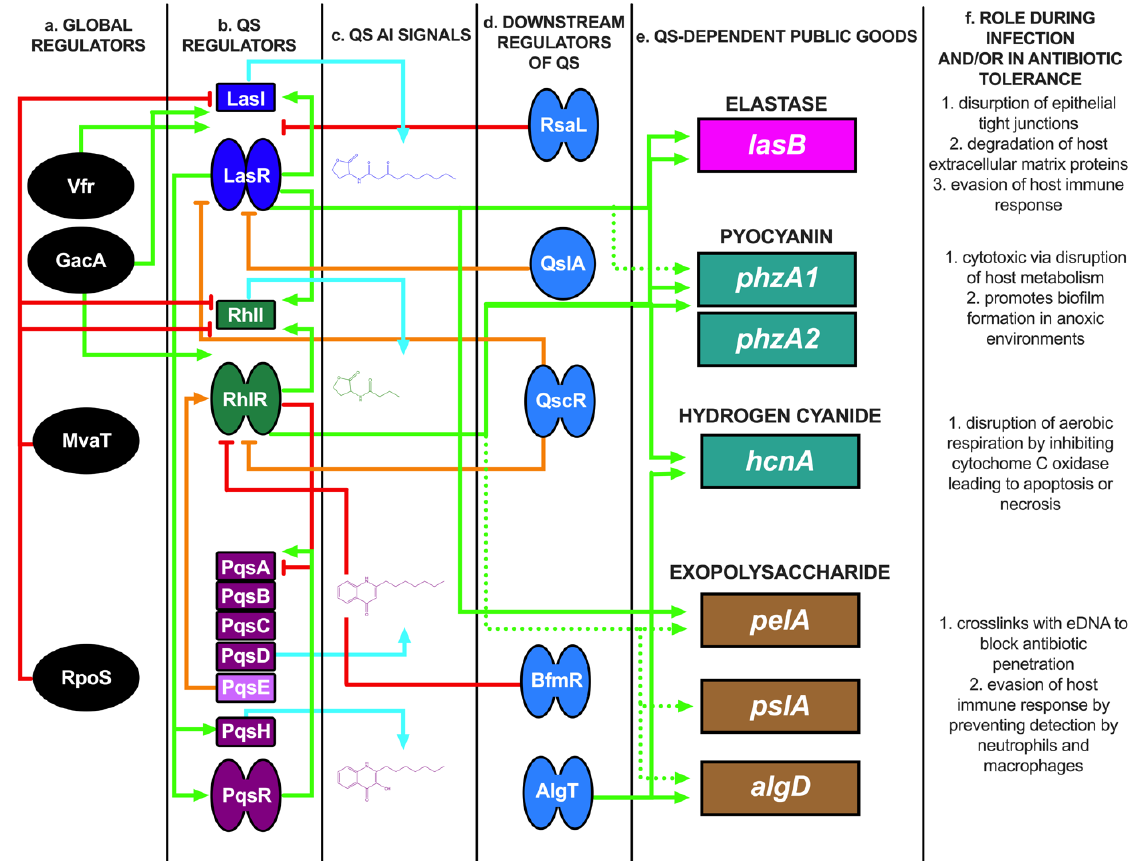
Figure 1. What regulates the regulators? Six steps from global gene regulation to infection and antibiotic tolerance. ( a ) A selection of well-characterized global transcriptional regulators that directly regulate the expression of the las and rhl QS systems. ( b ) The three main branches of QS regulators all regulate their own signal production through an autofeedback mechanism that results in the upregulation of their respective AI signals, as shown in ( c ). There is an extensive interplay between the three QS pathways. PqsE is colored light purple, distinct from the rest of the PQS pathway, because of its role outside of the biosynthesis of PQS related to regulating RhlR function. ( c ) The three main AI signals that bind to their cognate receptors in ( b ). HHQ, the precursor to PQS synthesis is shown because it can also act as an activator of PqsR. ( d ) Downstream regulators may or may not be QS regulated, but they exert their influence on QS by repressing the activation of QS through transcriptional regulation or binding to the receptors to disrupt their activation. ( e ) The totality of the regulation shown in a-d manifests itself in the timely expression of QS-dependent public goods. For simplicity, we highlight only the genes discussed in this review. ( f ) A summary of the effects each of the QS-dependent public goods has during host infection. Red bars indicate transcriptional repression. Green arrows indicate transcriptional activation. Blue arrows indicate AI production and binding. Orange bars and arrows indicate protein-protein interactions that result in activation and repression, respectively. Dotted green lines indicate indirect transcriptional activation. 3.3. The Rhl System Can Bypass the Requirement for Activation by the Las System Recent discoveries suggest that the canonical pathway of RhlR activation via LasR might not be as straightforward as previously thought; research on clinical isolates of P. aeruginosa has shown that RhlR-dependent transcription is upregulated in the presence of lasR inactivating mutations, indicating that RhlR can function in the absence of its proposed activator, LasR [18,76–80]. Furthermore, nutrient limiting conditions mimic those that P. aeruginosa would face in a host when establishing an infection (Box 1). Specifically, under phosphate-limiting conditions, the rhl system can function in the